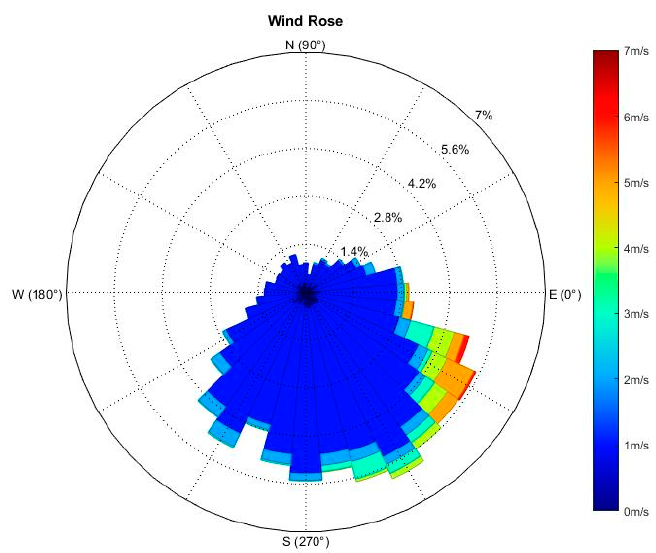
Figure 6. Speed, direction and frequencies of the wind near the oil released site (from 5–12 April 2015).